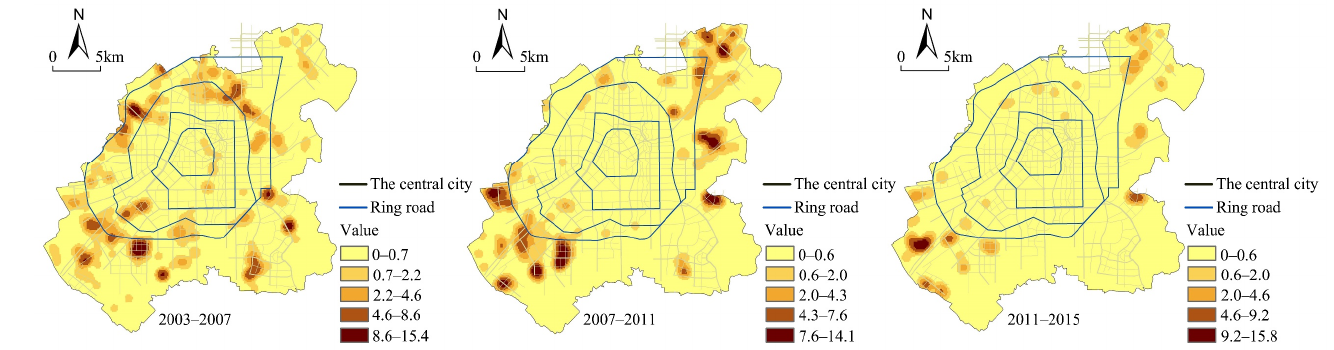
Figure 12. Kernel density map of industrial land expansion in different periods.